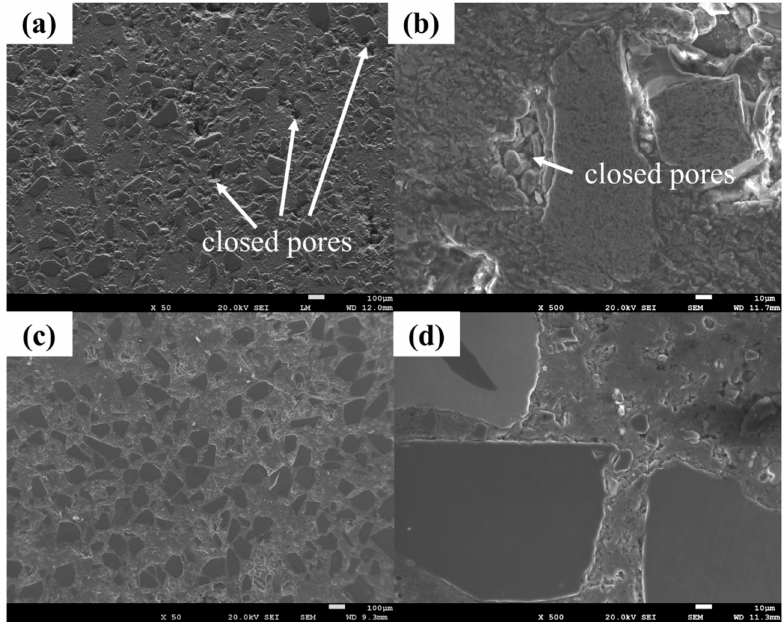
Figure 5. Representative SEM images showing the micromorphology of SiC/Al composites with ( a , b ) 10%; ( c , d ) 30% NH 4 HCO 3 added.